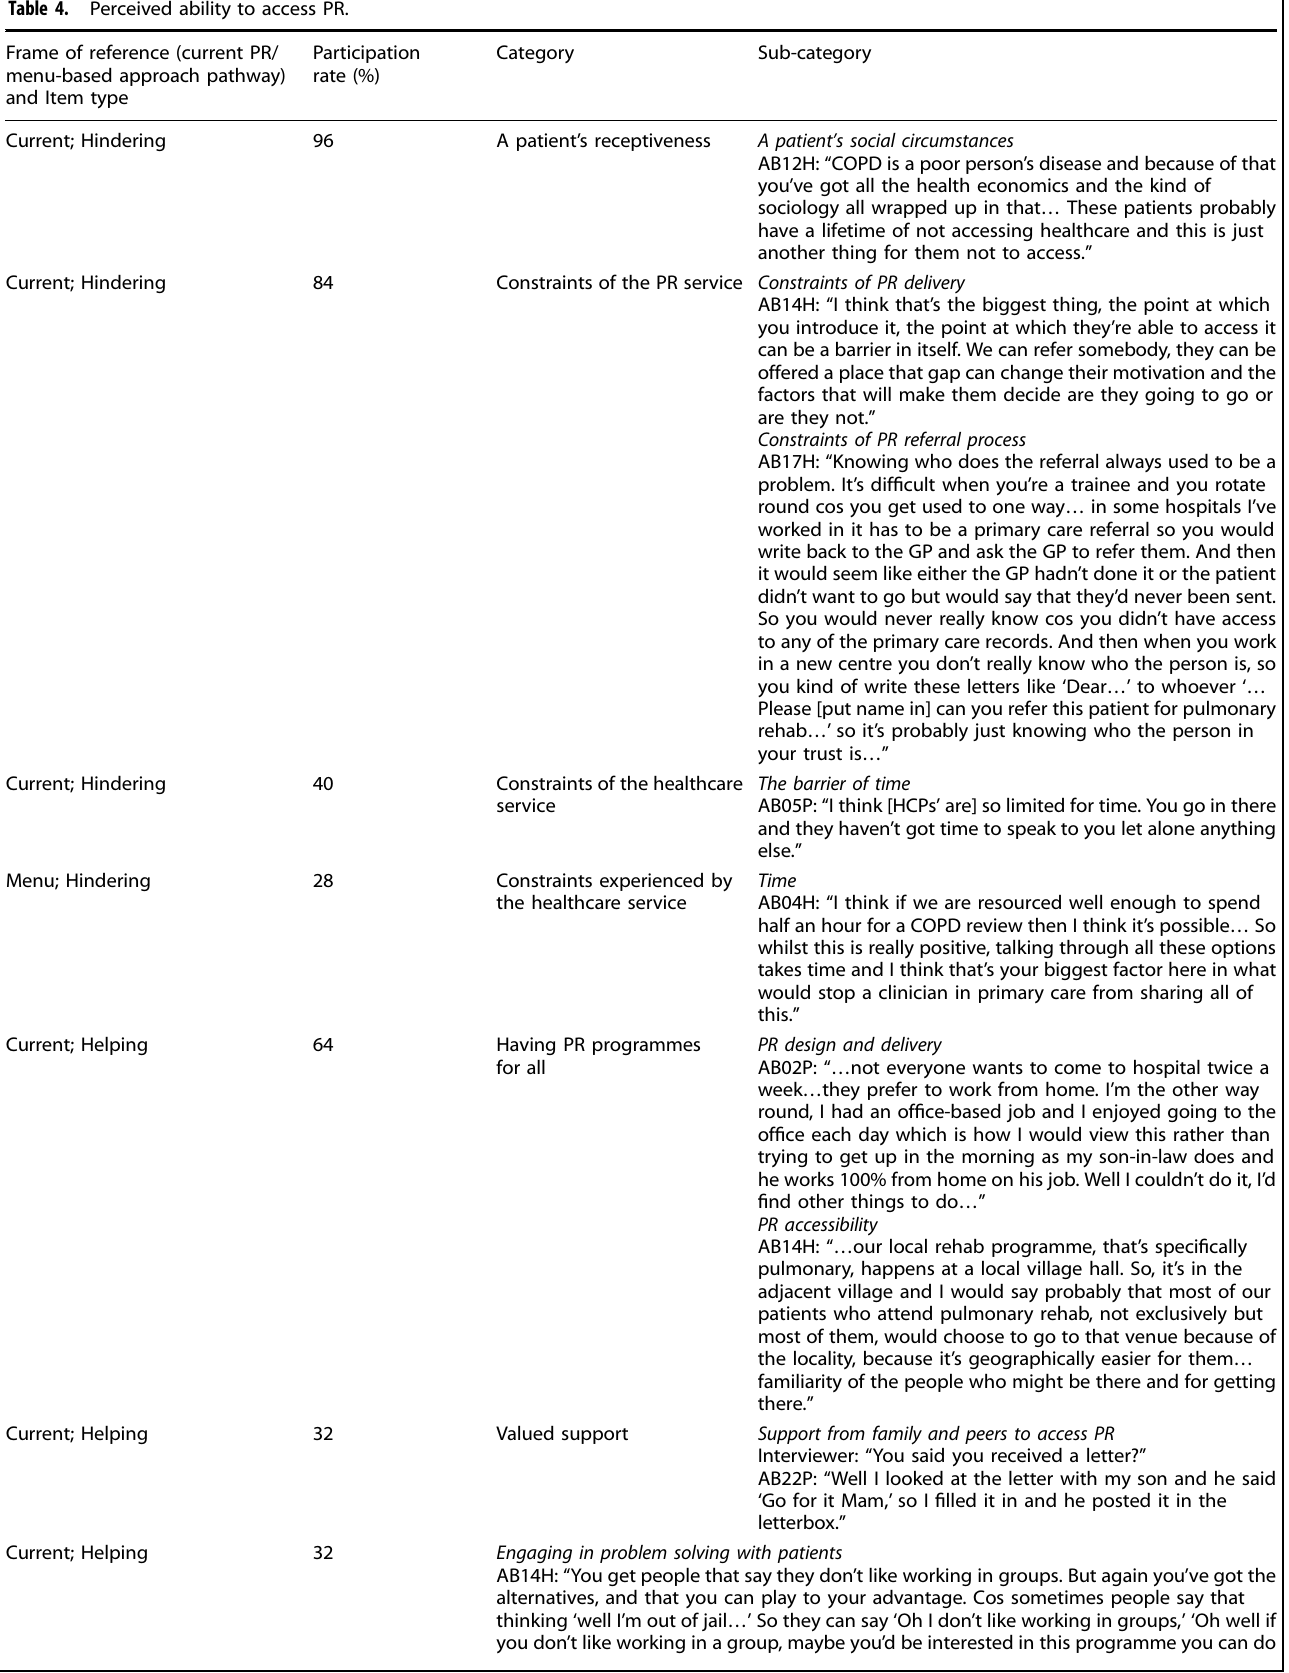
Table 4. Perceived ability to access